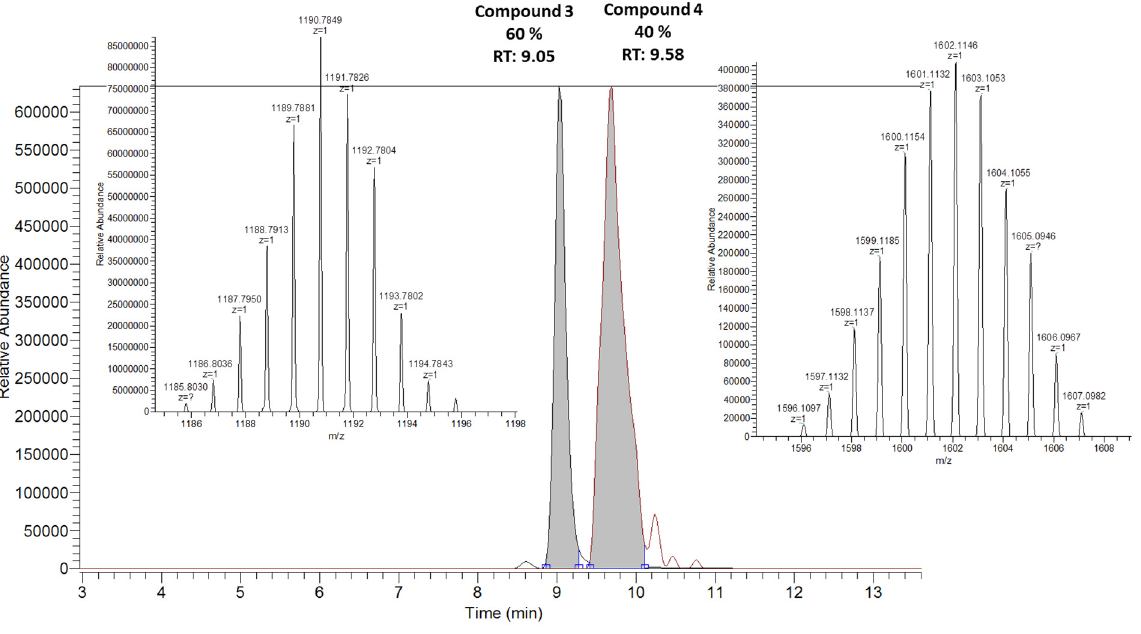
Figure 2. Total ion chromatogram of mixture of compound 3 (relative abundance = 60%, RT = 9.05 min, m / z [M + H] + = 1,190.7849) and compound 4 (relative abundance = 40%, RT = 9.58 min, m / z [M + H] + = 1602.1146).